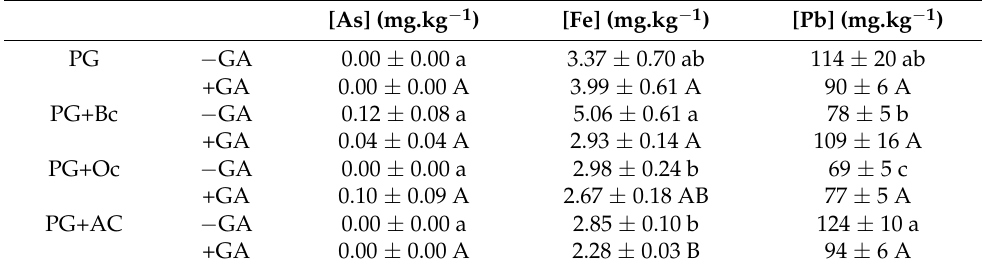
Table 3. CaCl 2 - extractable metal(loid) (As, Fe, Pb) concentrations (mg.kg − 1 ) determined at the end of the experiment in Pontgibaud technosol alone (PG) or amended with biochar (PG+Bc), ochre (PG+Oc), and activated carbon (PG+AC), associated or not with green amendment (+/ − GA). Small letters indicate a significant difference between the treatments without green amendment while capital letters indicate a significant difference between the conditions with the green amendment ( p < 0.05) (n = 5 ±